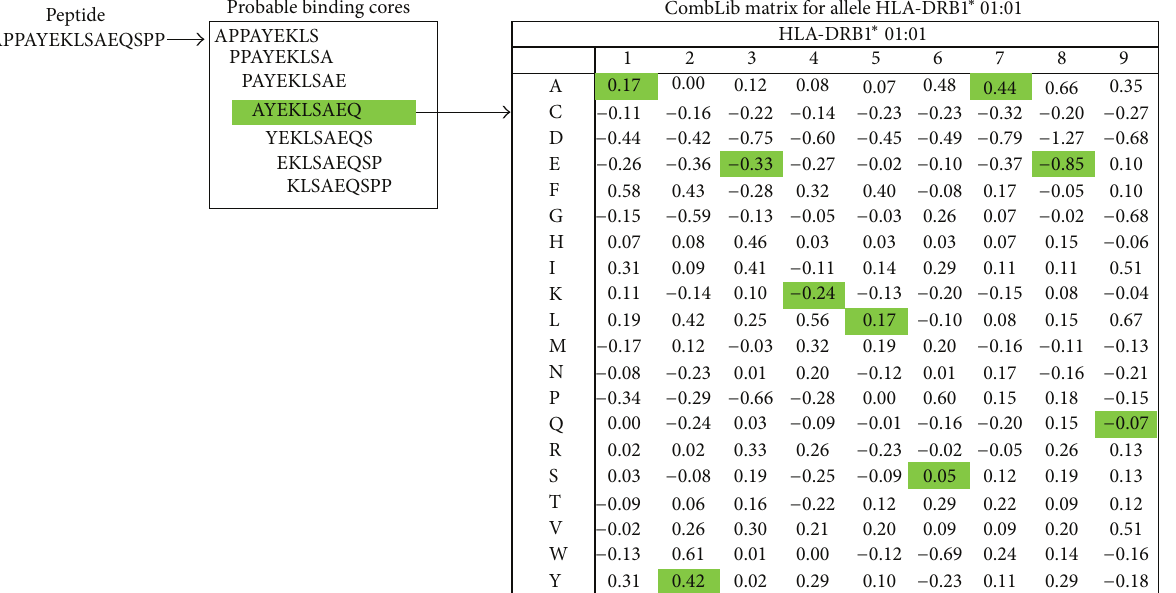
Figure 2: An example of matrices used to generate class II HLA prediction methods. Common prediction methods rely on the derivation of specific matrices that quantify the positive or negative contribution of the 20 different amino acid types to the overall binding affinity for each